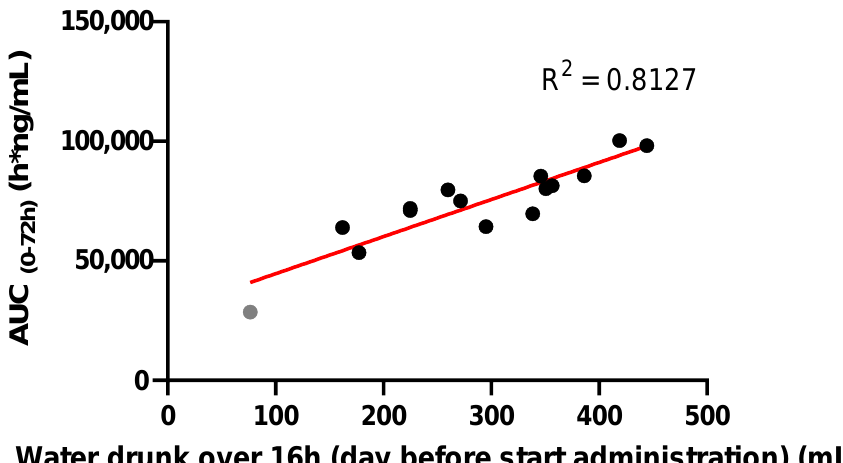
Figure 6. The correlation between AUC (0–72h) of enrofloxacin administered via the drinking water of 15 broiler chickens dosed at 20 mg/kg and the amount of water drunk over 16 h (the filming period) per bird the day before administration. Coefficient of determination (R 2 ) = 0.8127.